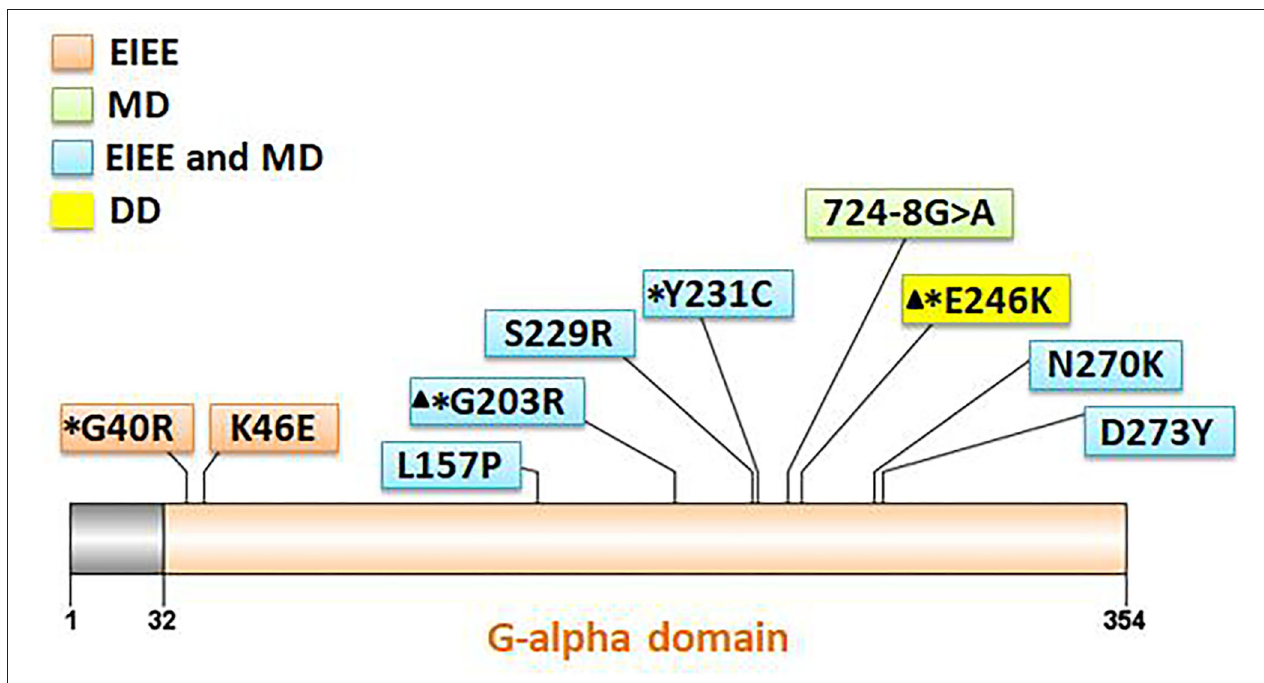
FIGURE 2 | Location of 10 GNAO1 variants in the G α o amino acid sequence. All variants are indicated corresponding to their locations within the gene. Variants with asterisks had been reported previously, and those with triangles are hotspot variants. Different background color of the box represents different phenotypes (orange: EIEE, early infantile epileptic encephalopathy; green: MD, movement disorder; blue: EIEE and MD; yellow: DD, development